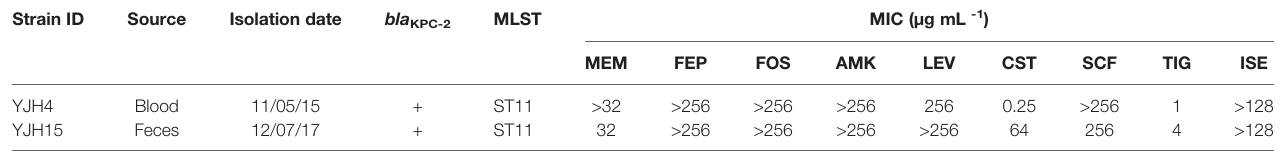
TABLE 1 | Phenotypic characteristics of K. pneumoniae strains YJH4 and YJH15. Strain